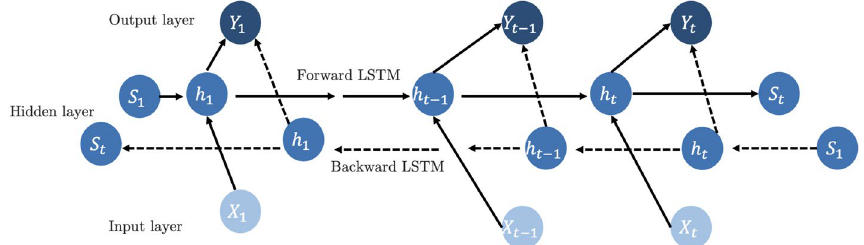
Fig. 2 Structure of Bi-LSTM network that both processes past and future